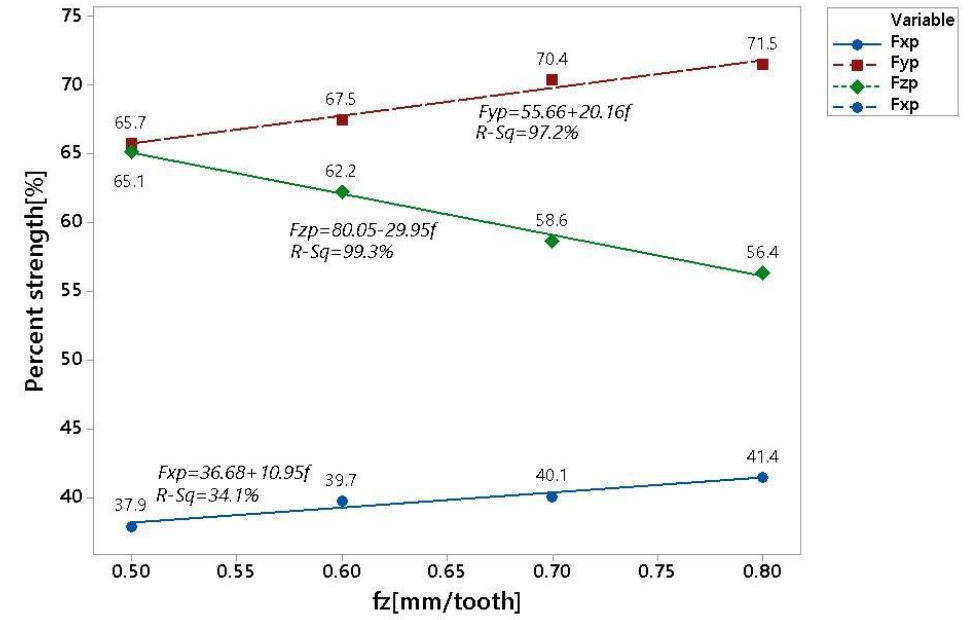
Figure 4. Graphical representation of cutting force ratios. The displayed results were further statistically examined using linear regression, where the individual points were interpolated with a straight line, the parameters of which can be found in Table 7. The displacement value along the vertical axis is expressed by the parameter Abs, and the angle of inclination of the interpolated line is expressed using the parameter f. Table 7. Results of linear regression.